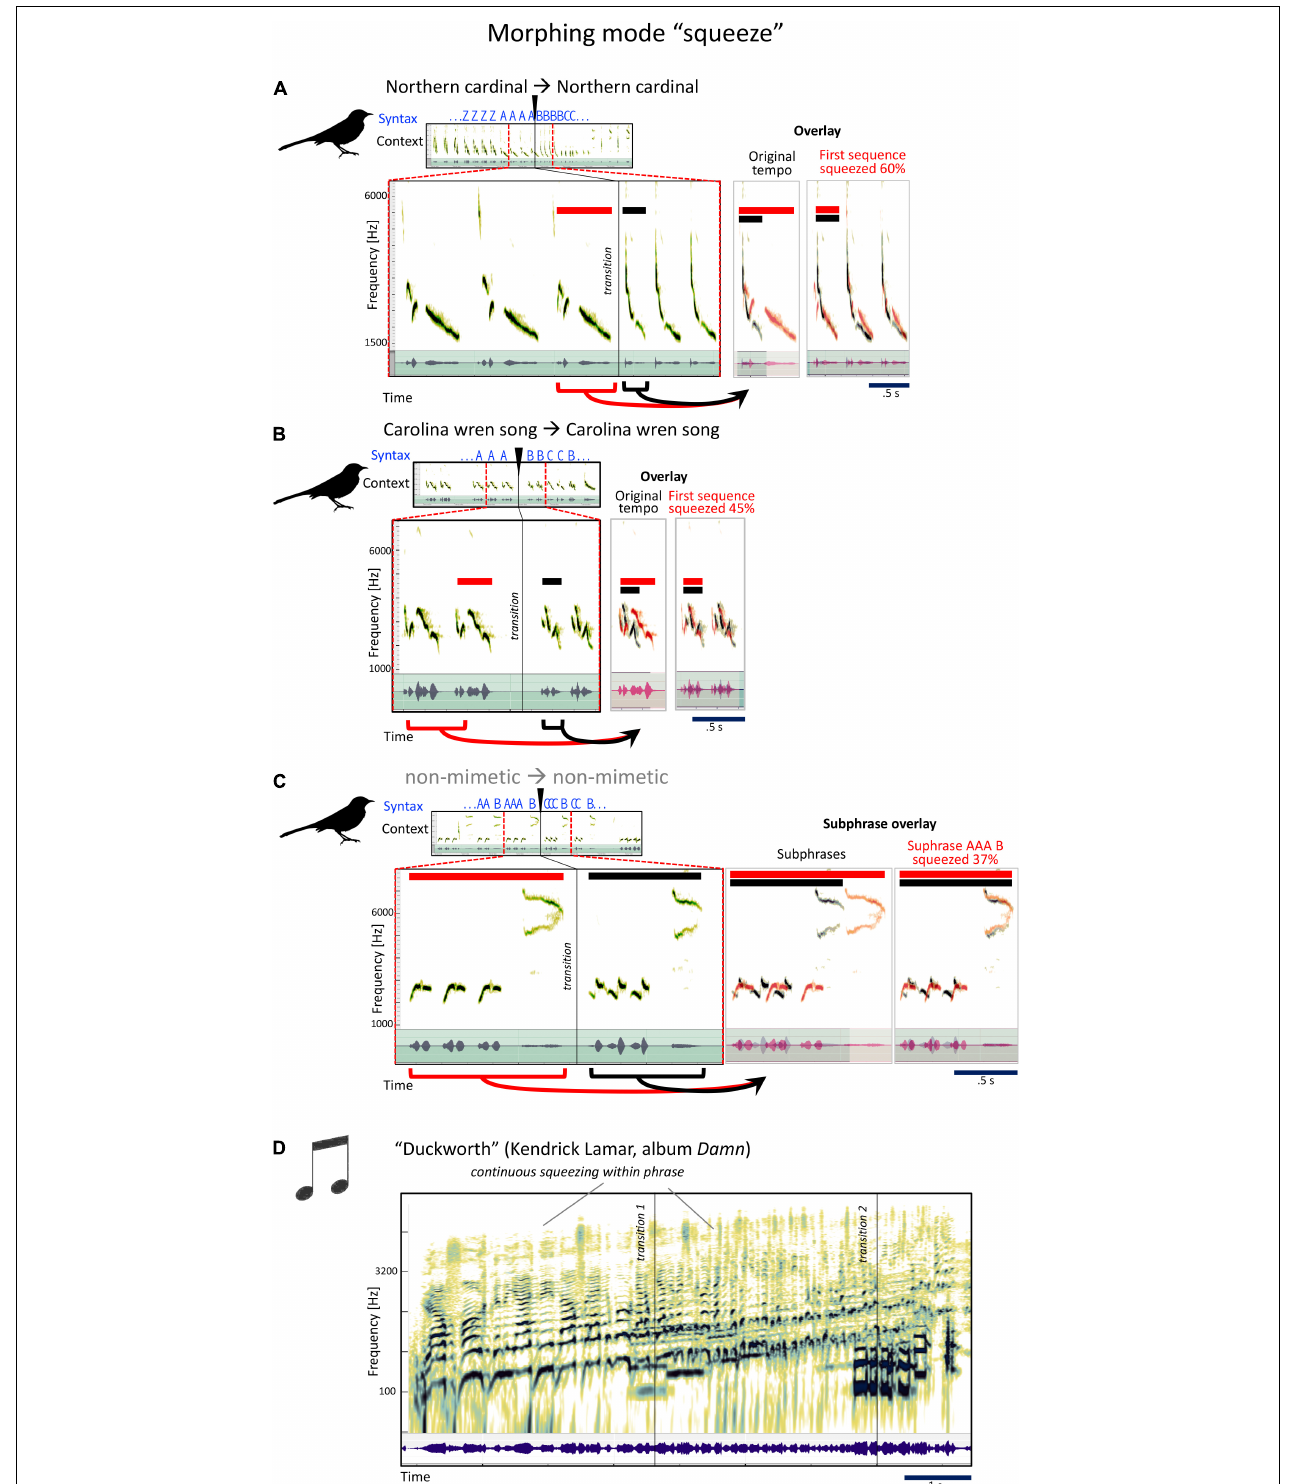
FIGURE 7 | Examples for the mockingbird morphing mode “squeeze,” and example for a similar musical strategy. (A–C) Spectrograms and waveforms (as in Figure 4 ) for three examples of phrase transitions representing “squeeze” morphing, in which a phrase is followed by a similar, but sped-up phrase. (D) Kendrick Lamar’s song “Duckworth” contains a section that uses a similar strategy of speeding up (here, however, the acceleration is more continuous than in the mockingbird examples).